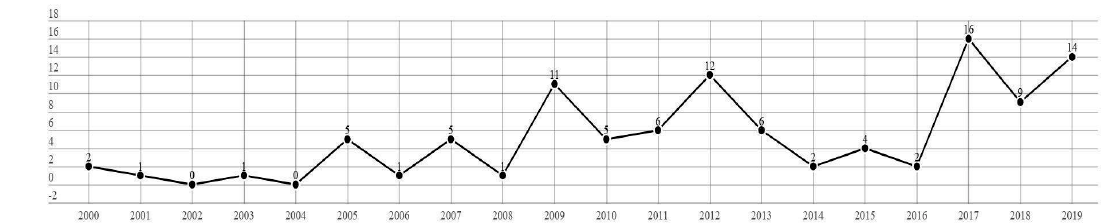
Figure 1. Timeline of total mentions (n = 103) of ‘climate change’ between 2000 and 2019.